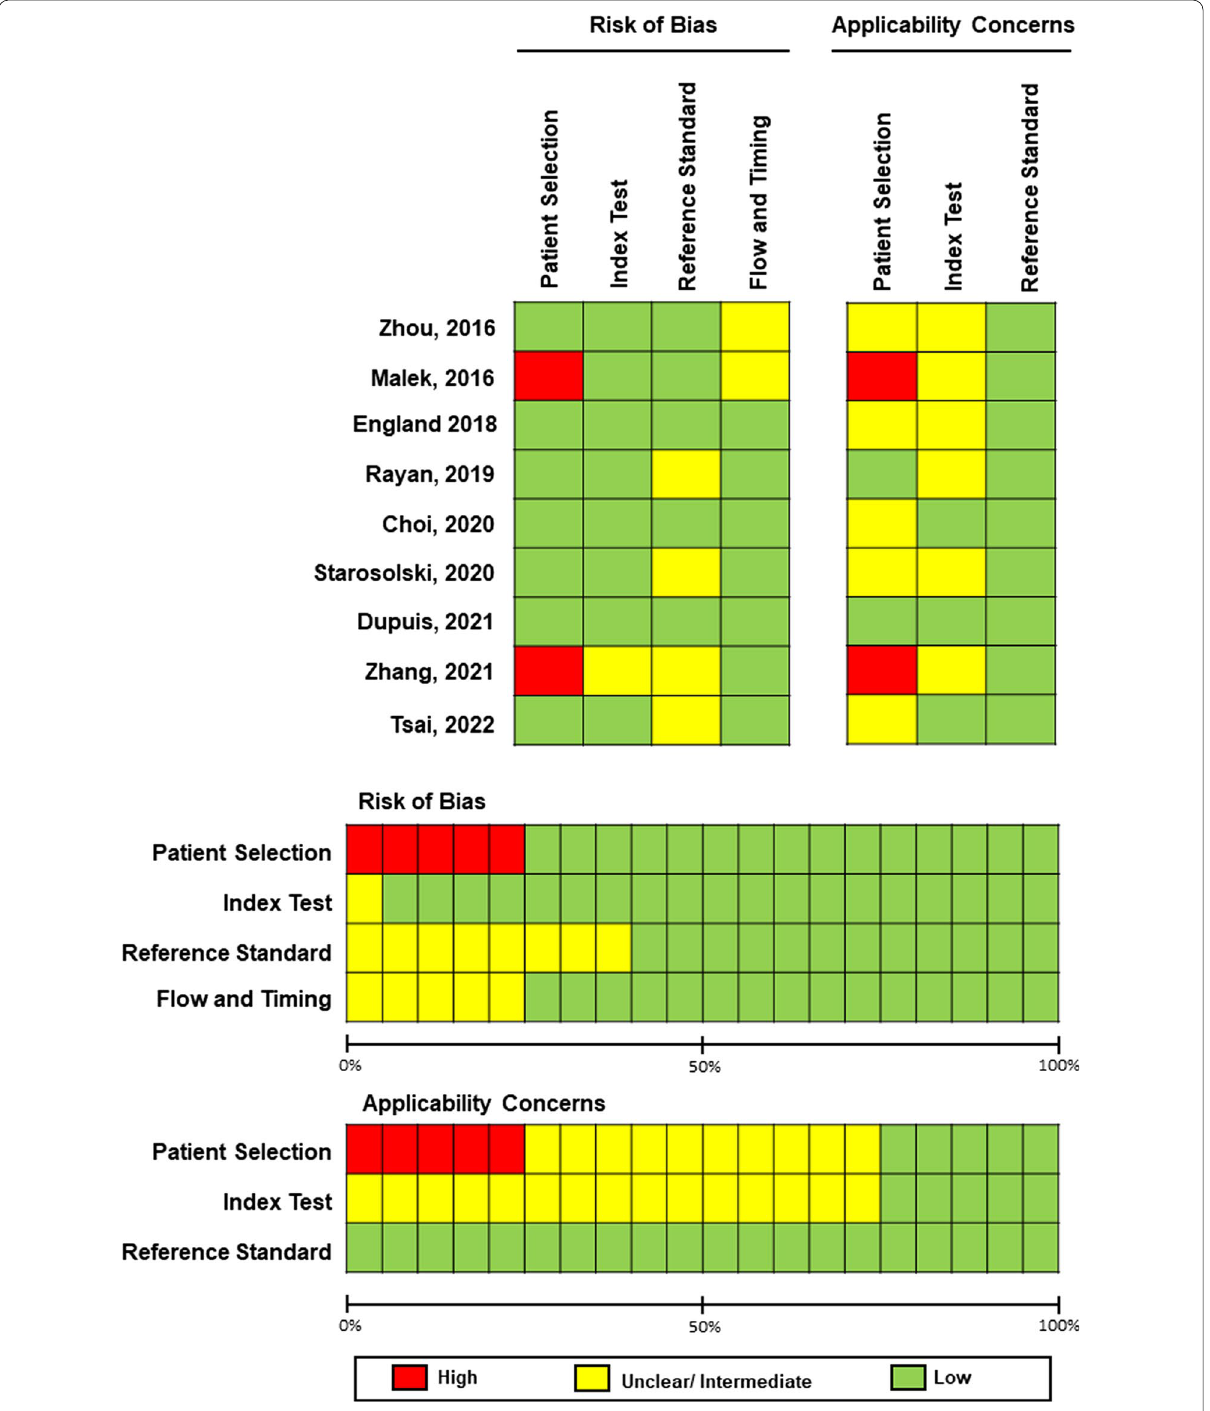
Fig. 2 Methodological quality assessment of the included studies using the QUADAS-2 tool. Risk of bias and applicability concerns summary about each domain are shown for each included